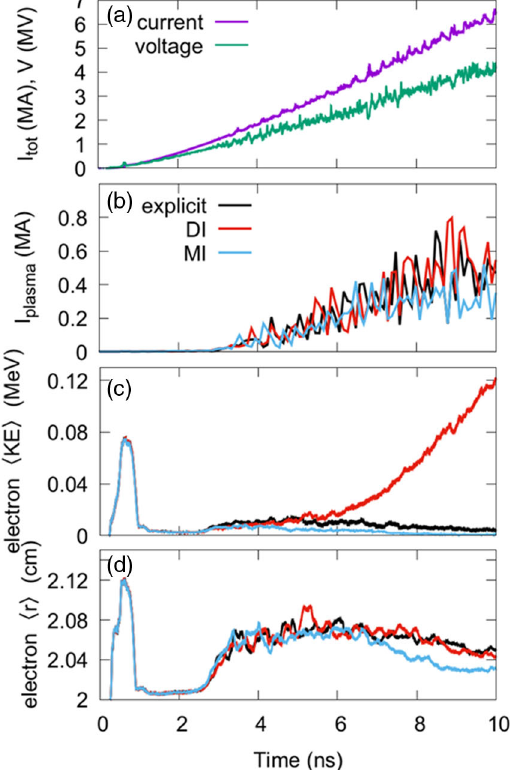
FIG. 3. Comparison of three particle push algorithms (DI, MI, and a standard energy-conserving explicit algorithm) applied to cathode plasma generation in a 7 - Ω coaxial transmission line. Plotted are (a) the load current and voltage, (b) the plasma current, (c) the mean electron energy, and (d) the mean electron radial extent averaged over 1 cm